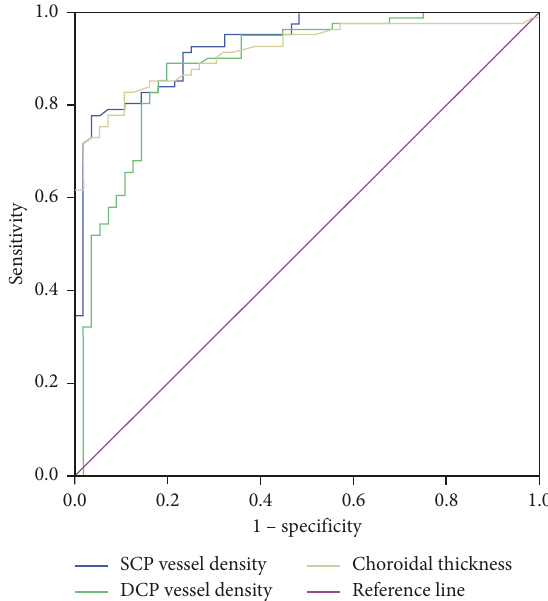
Figure 3: Receiver operating characteristic curves of the vessel densities in the superficial retinal capillary plexus and deep retinal capillary plexus and choroidal thickness for predicting diffuse chorioretinal atrophy. SCP � superficial retinal capillary plexus; DCP � deep retinal capillary